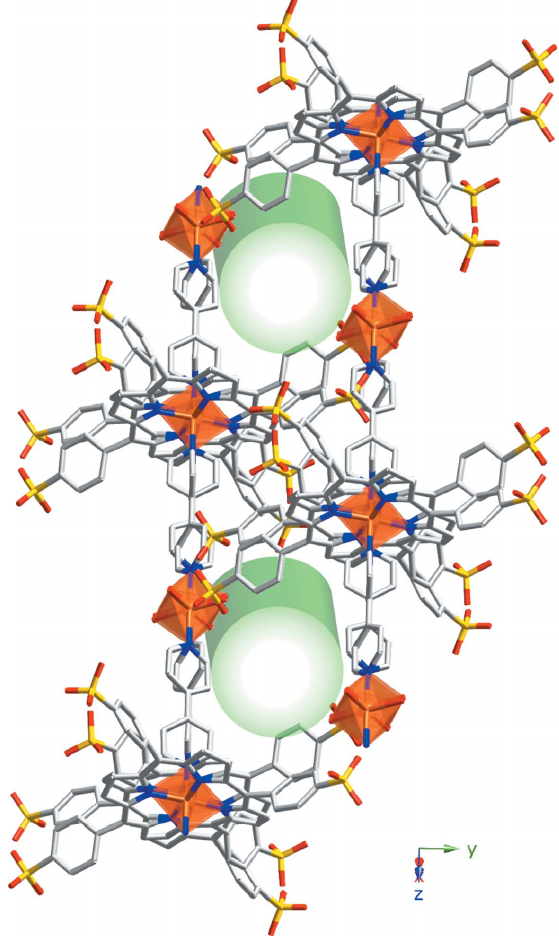
Figure 4 Representation of the accessibility of guest molecules to the active metal centres for compound 3. Colour code: Co orange, C grey, N blue, O red and S yellow. Accessible pathways are represented by the green cylinders.